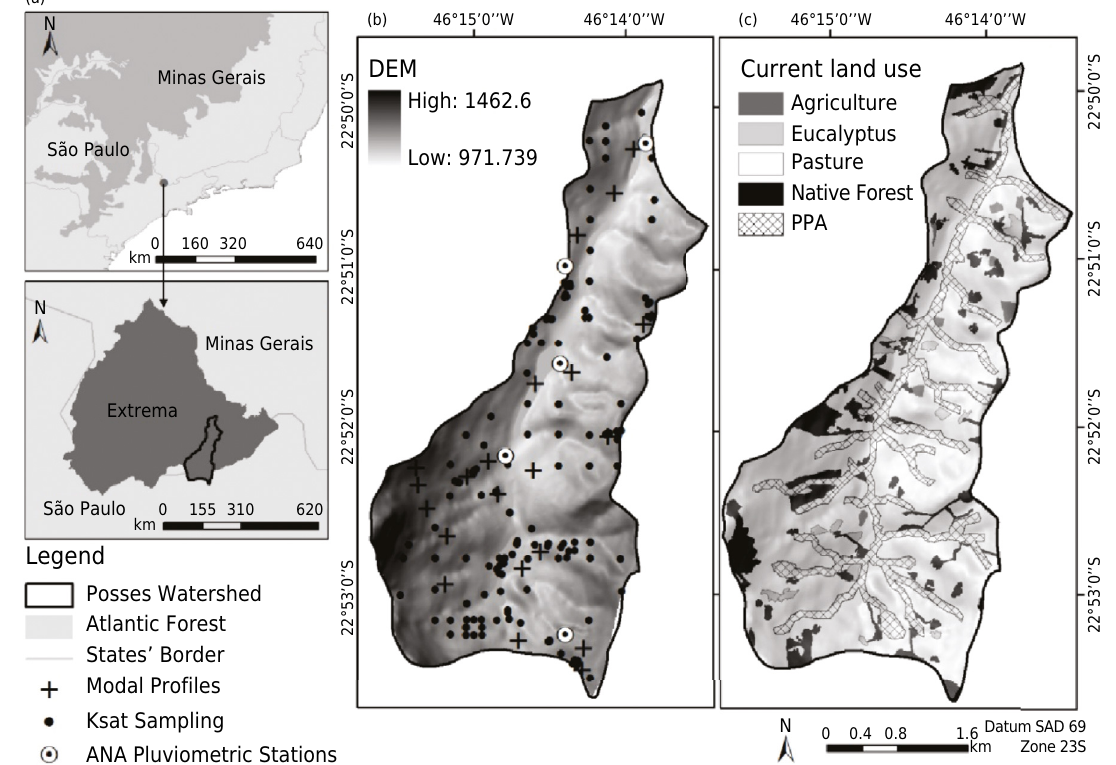
Figure 1. Location of the study area (a), soil profiles, sampling points of the saturated hydraulic conductivity (Ksat), pluviometric stations of the National Water Agency (ANA), digital elevation model (DEM) with resolution of 10 m (b) and current land use including the permanent preservation areas (PPA)